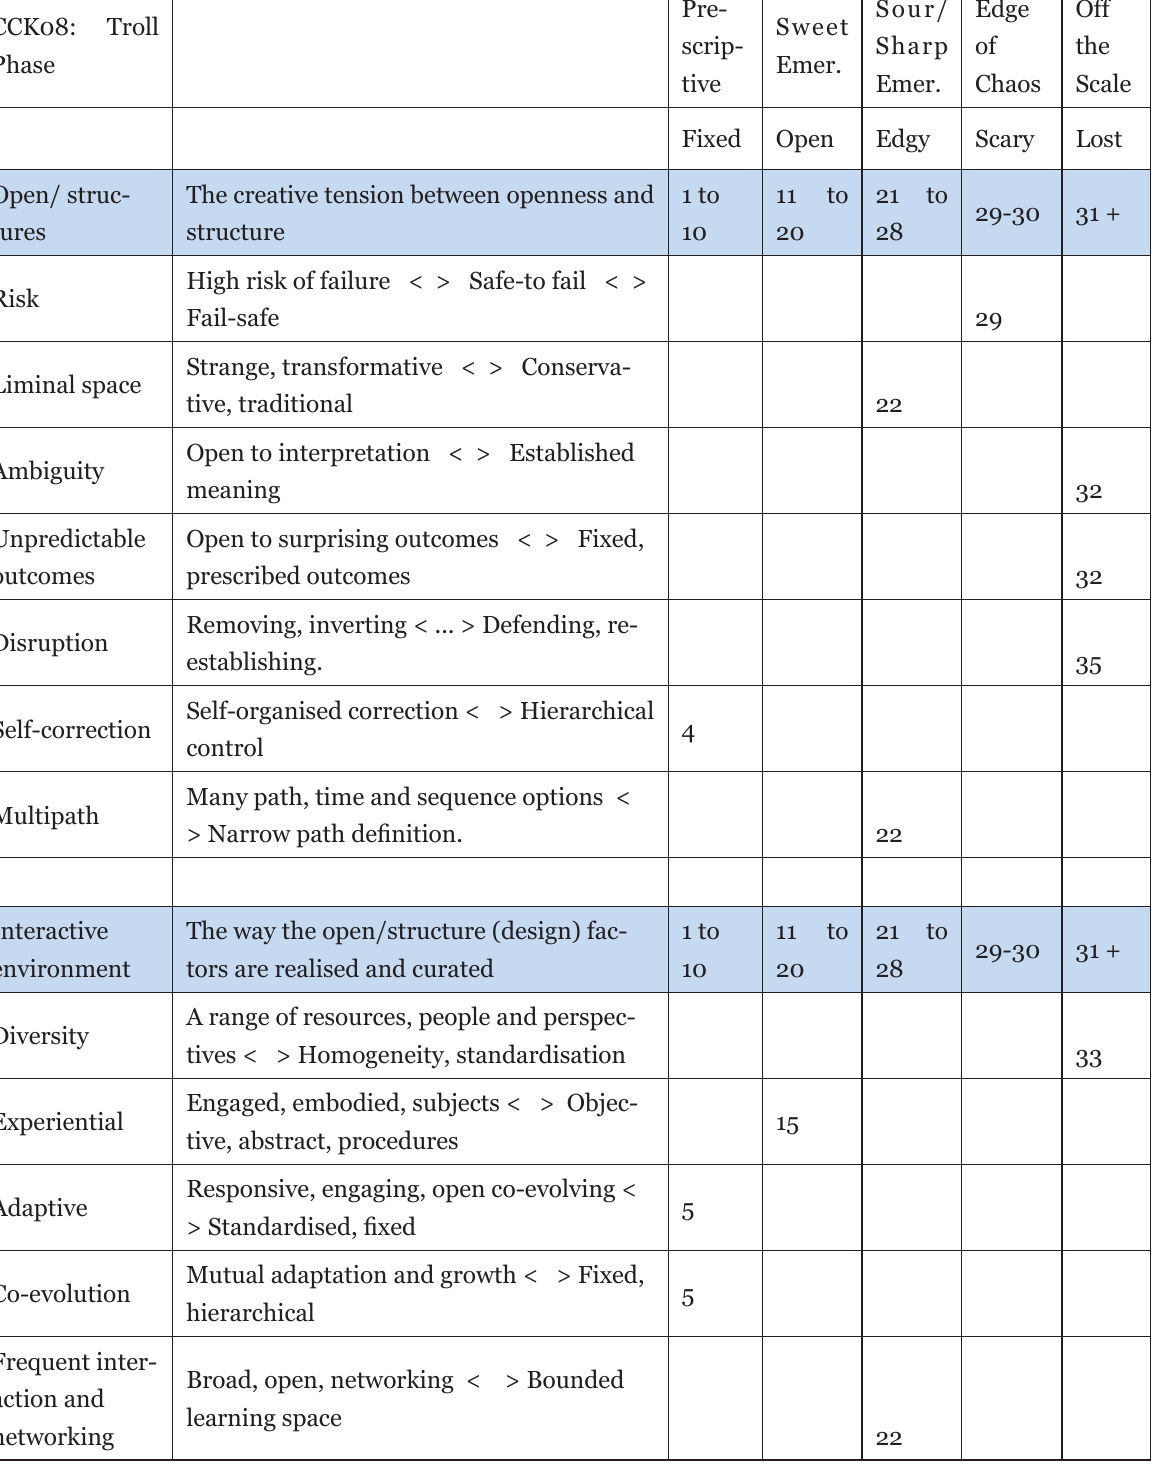
Table 3a The Open/Structure and Interactive Environment Clusters, Troll Phase of